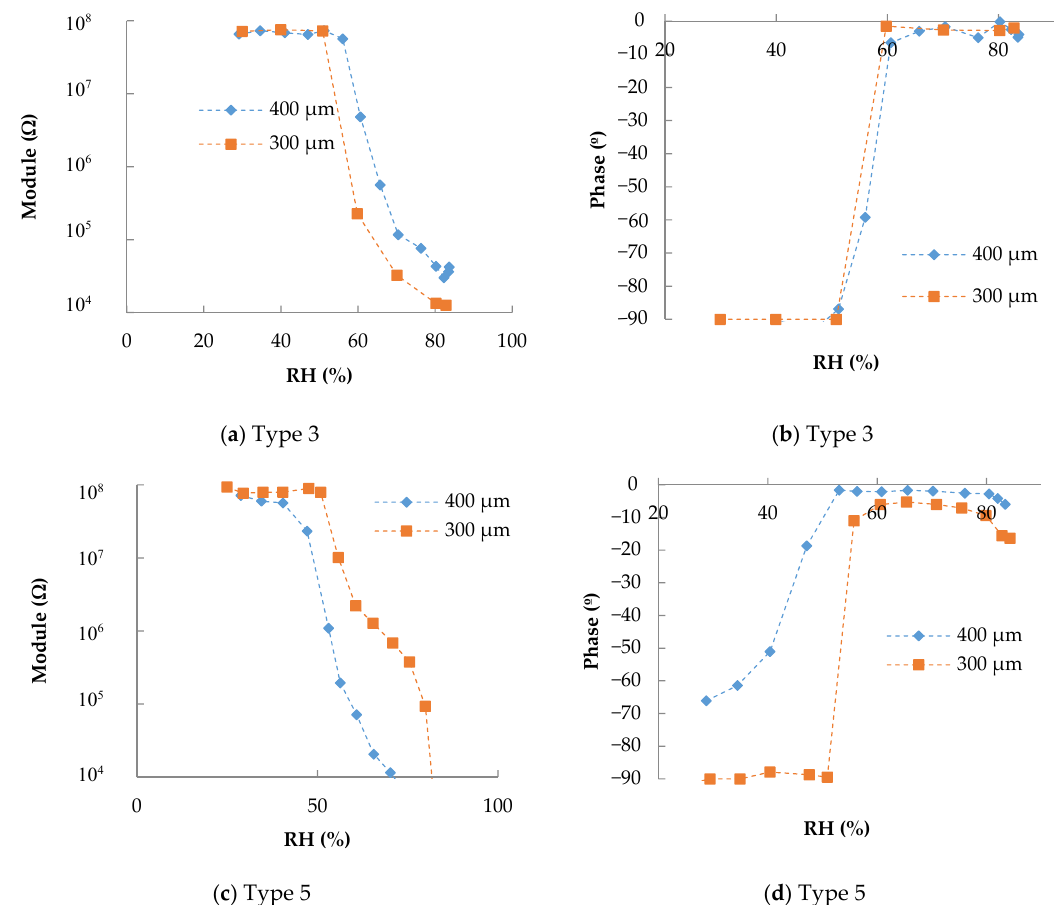
Figure 4. Impedance response towards RH at 100 Hz and 40 °C for different spacing: ( a ) module and ( b ) phase for type 3; ( c ) module and ( d ) phase for type 5.